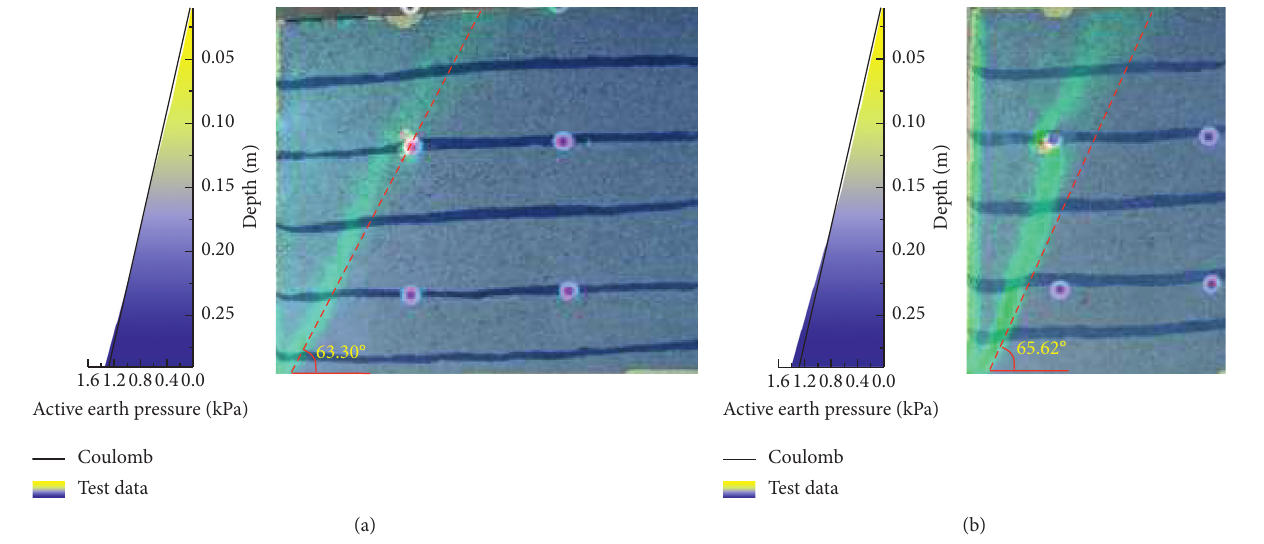
Figure 4: Strain contour of approximate semi-infinite soils.